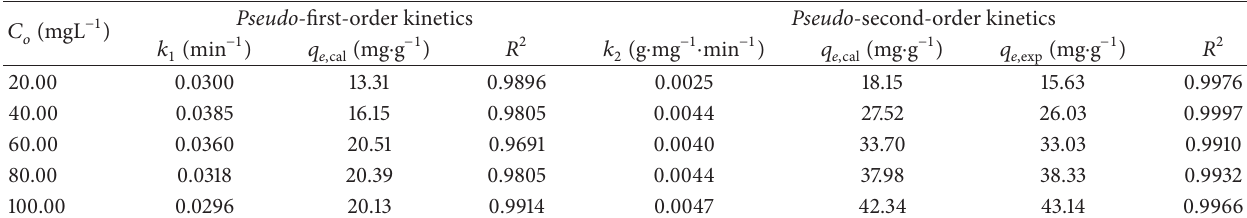
Table 3: Adsorption kinetic parameters for Pb(II) adsorption on the Fe 3 O 4 /rGO composite. −1 ) Pseudo -first-order kinetics Pseudo -second-order kinetics 𝐶 𝑜 (mgL